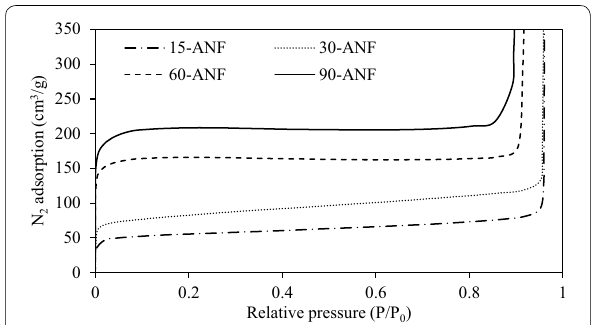
Fig. 2 N 2 /77 K isotherm of physically activated